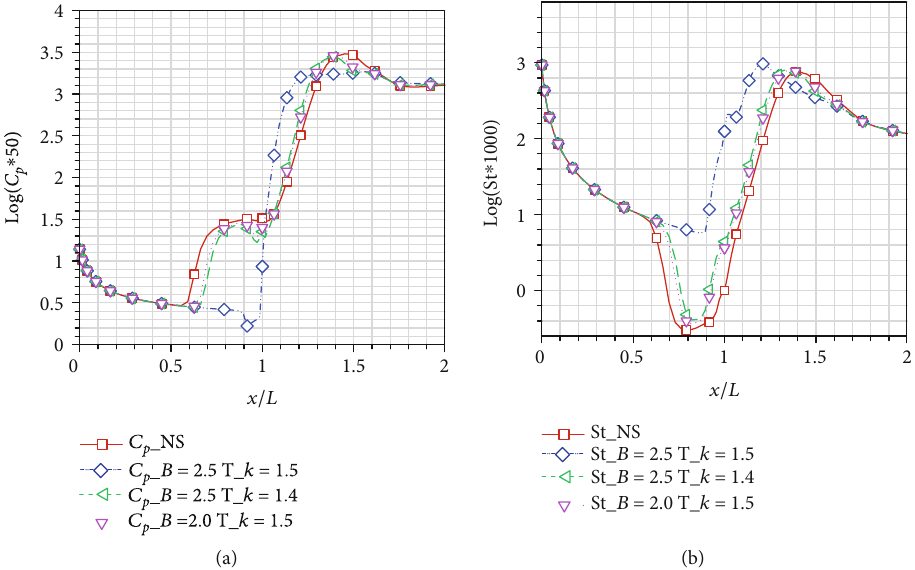
Figure 14: E ff ect of the electromagnetic fi eld strength on the wall pressure and wall heat transfer distribution: (a) wall pressure distribution; (b) wall heat transfer